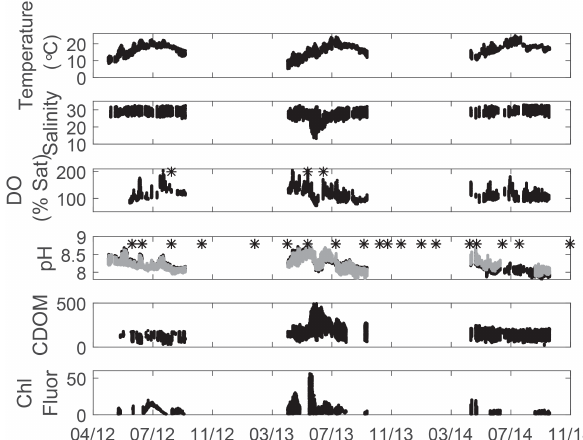
Figure 6. FerryBox data from M/V Funny Girl for temperature, salinity, dissolved oxygen (DO, % saturation), pH, CDOM and chlorophyll fluorescence between May 2012 and October 2015. For pH, there were two electrodes, one in black and the other in gray. The ferry data are a compilation of all transects between Büsum and Helgoland. Data along the entire ferry transect are used; therefore the figure captures the change along the ferry transect (vertical data range) with time. The stars on the DO and pH panels signify service dates, when the DO optode was changed or when the pH electrodes were